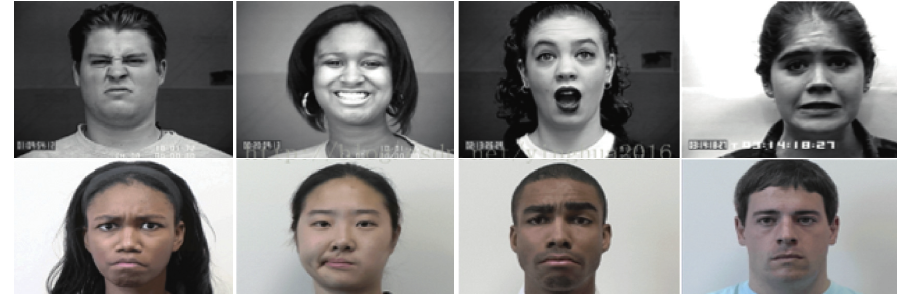
Figure 6: Sample facial images from the CK+ dataset.